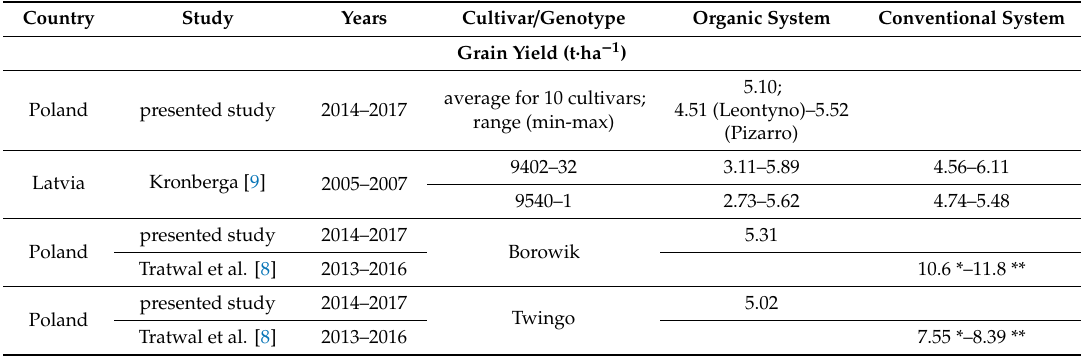
Table 9. Comparison of triticale grain yields in organic and conventional farming systems based on own research and